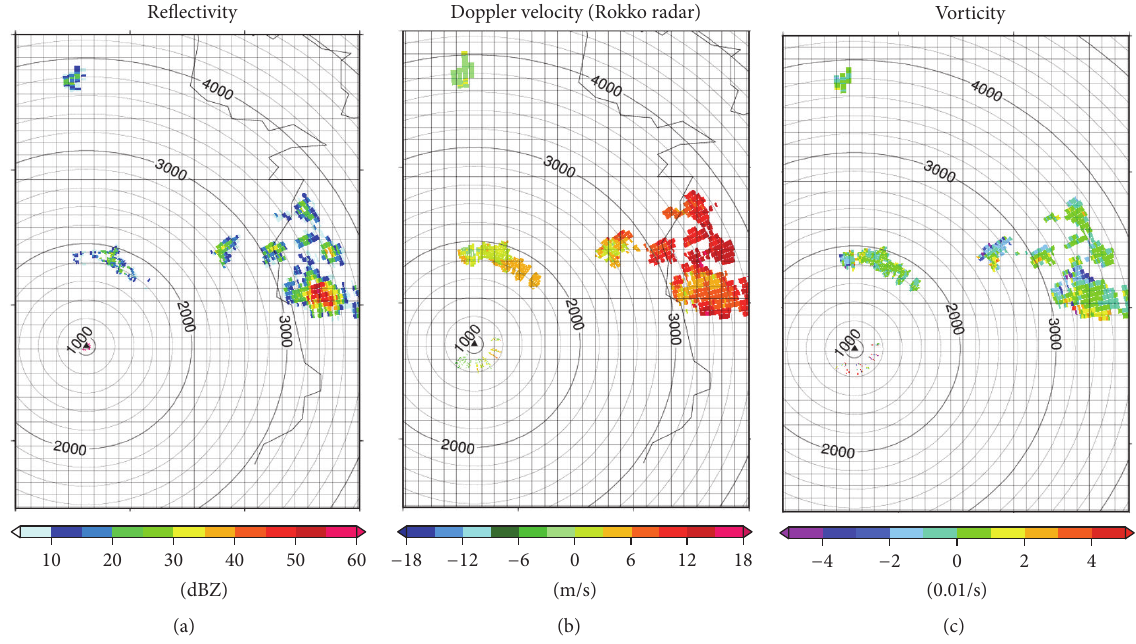
Figure 12: One example of distributions of reflectivity (a), Doppler velocity (b), and vorticity (c) after data processing.